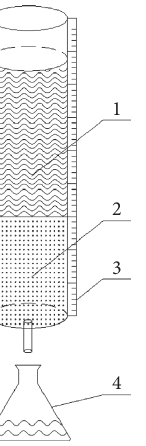
Figure 4: Oil adsorption experiment device. (1) Oil; (2) adsorbent; (3) tick line; (4) collection bottle.